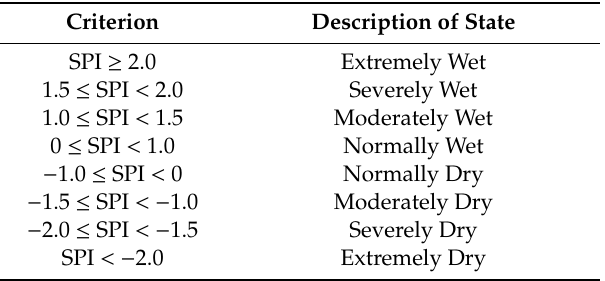
Table 1. Definition of states of meteorological drought with SPI.